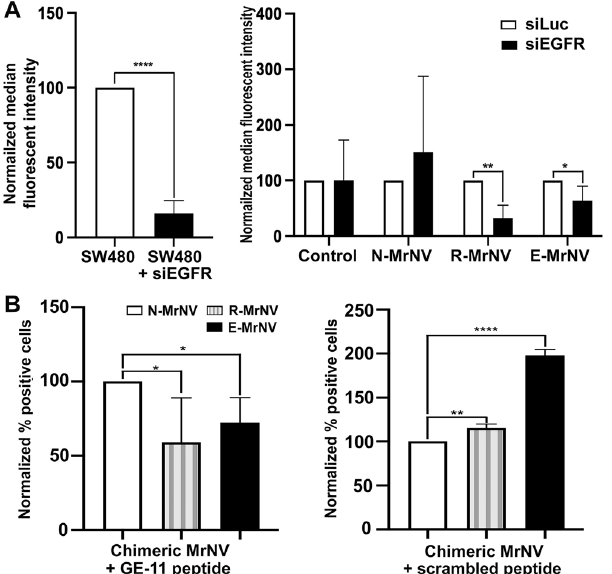
Figure 4. Inhibition of chimeric VLP binding through a silencing of EGFR by siRNA or interference with GE-11 peptide. SW480 cells were treated with siRNA against EGFR ( A ) or with GE11 peptide ( B ) prior to incubation with chimeric Mr-NV-VLPs and quantified the binding by flow cytometric analyses. Controls were SW480 cells treated with siRNA against luciferase ( A , siLuc) or scramble peptide ( B ). * and ** denote statistical differences at p < 0.05 and 0.01, respectively (Student’s t test, n = 3, graphs represent mean ± SEM).